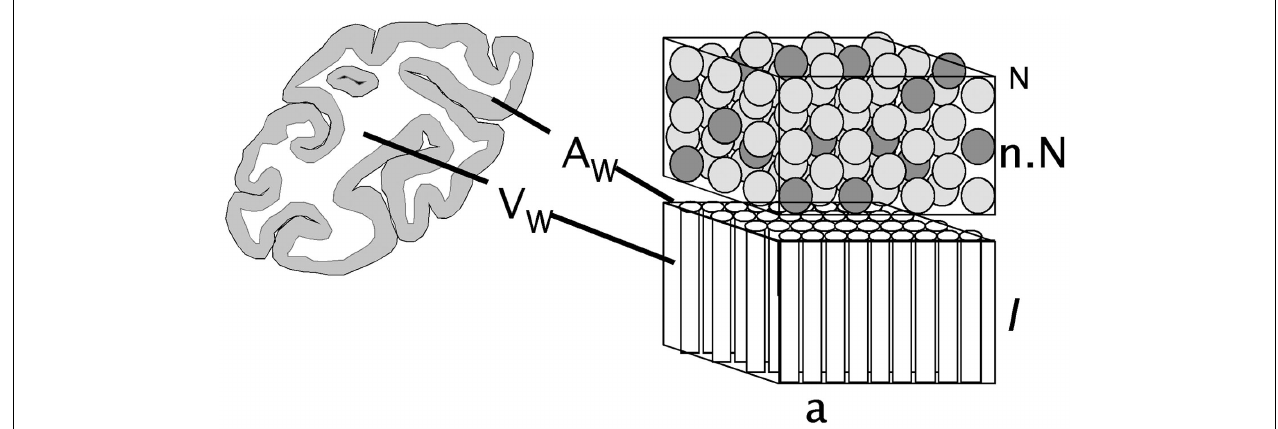
Glial cells, which have been found to be distributed at a fairly constant density across species (Herculano-Houzel, 2011), are not shown.The surface area of the interface between the gray and white matter, A W , is given as the product nNa , and the volume of the white matter, V W , is proportional to the product of A W and the average axonal length in the white matter, l